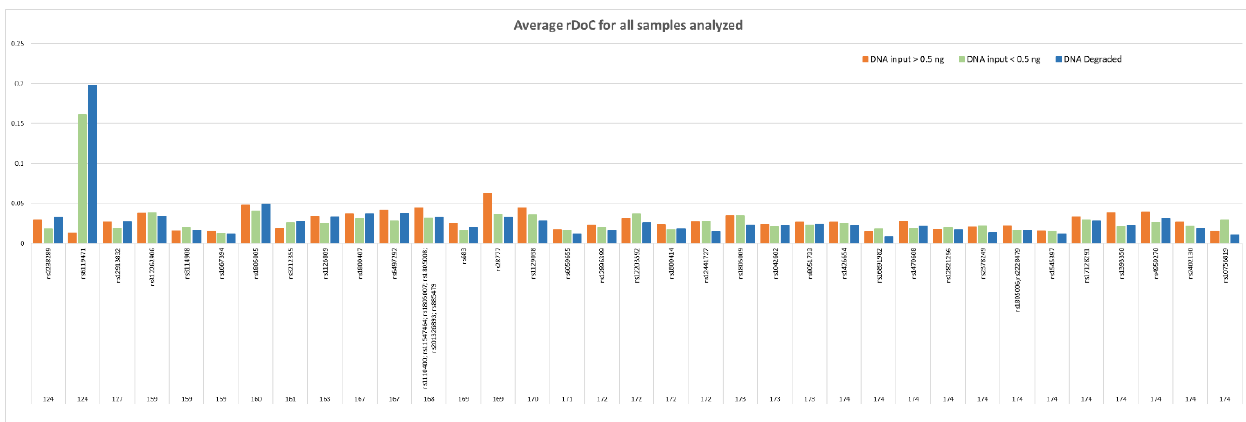
Figure 2. Comparison of average rDoC distribution observed in non-degraded samples (DNA input > 0.5 ng and DNA input < 0.5 ng) and DNA degraded samples. X -axis: mean relative depth of coverage (rDoC) value; Y -axis: polymorphisms included in the amplicons together with the amplicon size.